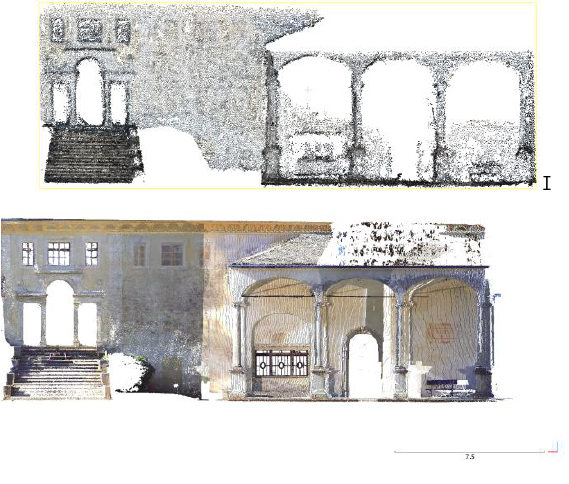
Figure 17. The compared point clouds segments: from VisualSfM (I) and from TLS survey (II).